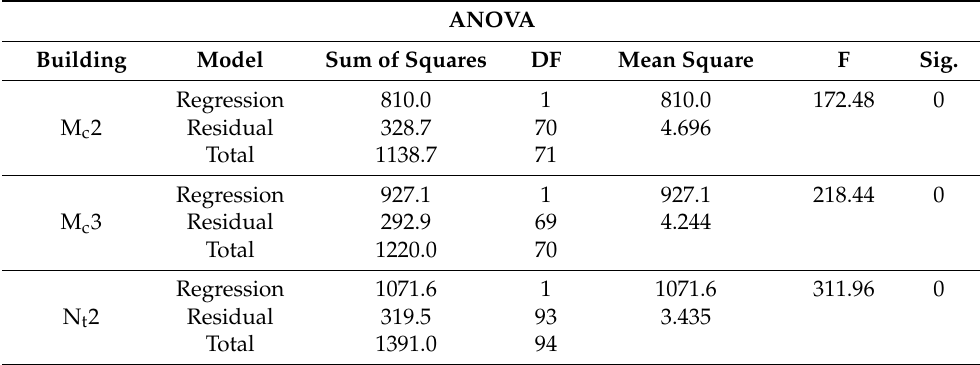
Table 6. Analysis of variance between measured and modelled data for PM 2.5